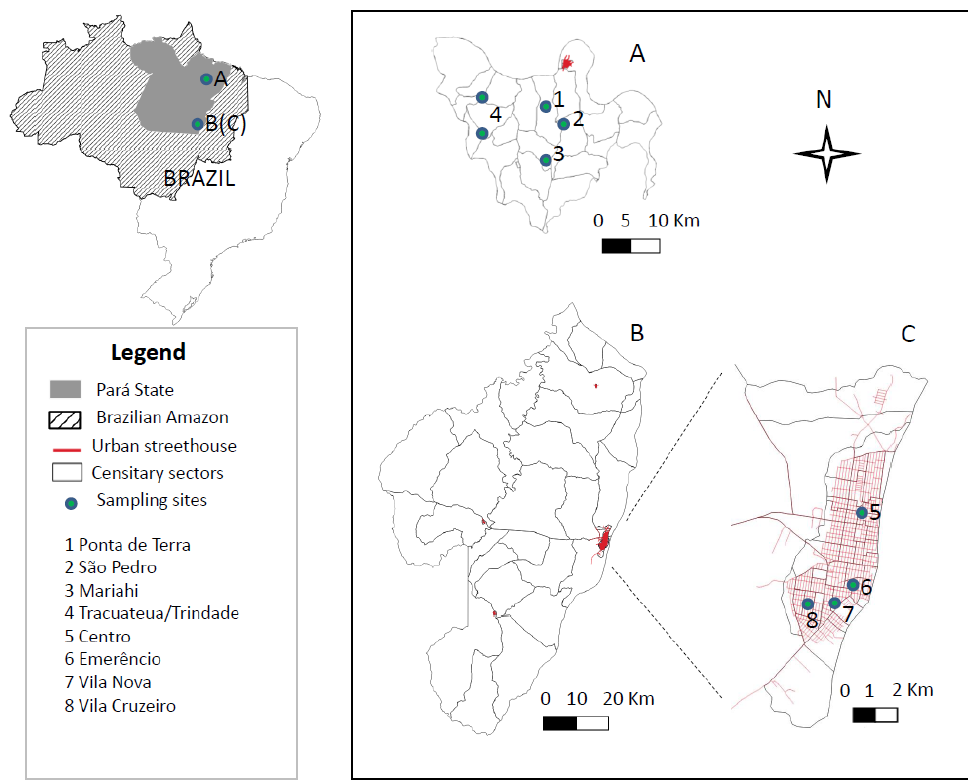
Figure 1. Two distinct epidemiological scenarios in the Brazilian Amazon: the Bujaru municipality in northeastern Pará State (01°30′54″ S: 48°02′41″ W), rural area ( A ), and Conceição do Araguaia in northeastern Par á State (01 ◦ 30 (cid:48) 54 (cid:48)(cid:48) S: 48 ◦ 02 (cid:48) 41 (cid:48)(cid:48) W), rural area ( A ), and Conceiç ã o do Araguaia municipality, in southeastern Pará State (49°15′53″ S: 49°35′53″ W ( B ), showing the urban area ( C ). municipality, in southeastern Par á State (49 ◦ 15 (cid:48) 53 (cid:48)(cid:48) S: 49 ◦ 35 (cid:48) 53 (cid:48)(cid:48) W ( B ), showing the urban area ( C ). The two areas are approximately 900 km apart. The two areas are approximately 900 km